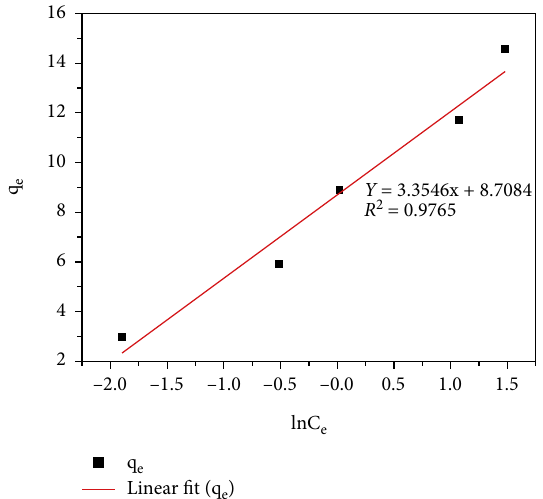
Figure 14: Timken isotherm model for adsorption of Pb (II) on CMNB at pH of 6, contact time of 50min, and adsorbent dosage of